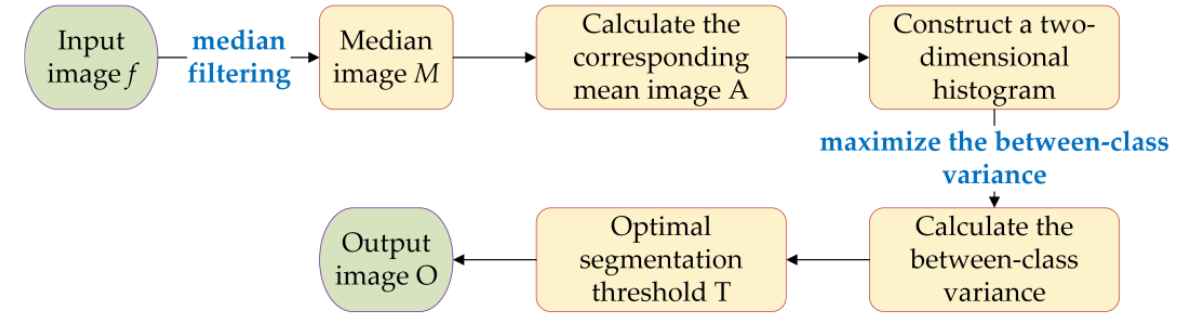
Figure 4. Flow chart of the algorithm. Algorithm 1 Improved Otsu method